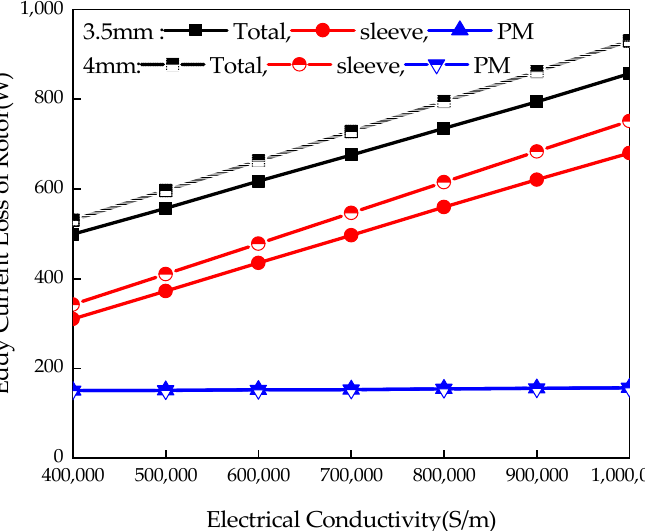
Figure 5. Result of eddy current loss analysis on the rotor with different conductivity and thickness.